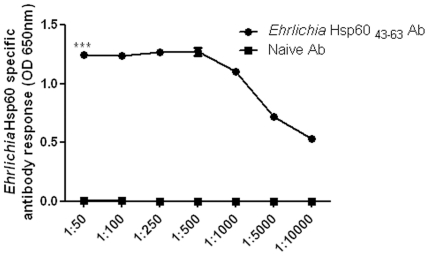
Reactivity of Ehrlichia Hsp60 antibody.The Ehrlichia Hsp60 43–63 peptide was sensitive in detecting different dilutions of the Ehrlichia Hsp60 antibody. The Ehrlichia Hsp60 (250ng) was probed with different dilutions of Ehrlichia Hsp60 specific sera or sera from naïve mice. Finally they were probed with goat anti-mouse-AP (1∶2000) and the OD measured at 650 nm after the addition of substrate. Each value is the mean of 3 replicates (***p<0.001 as determined by two way ANOVA).